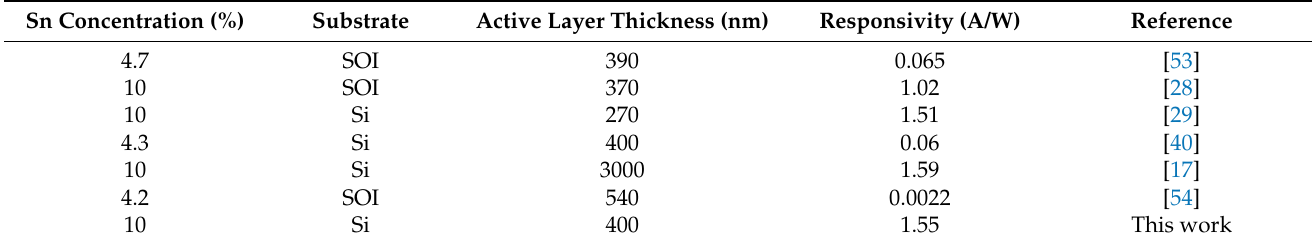
Table 2. Comparative study of the optimally designed GeSn WGPD with previously reported GeSn PDs at T = 300